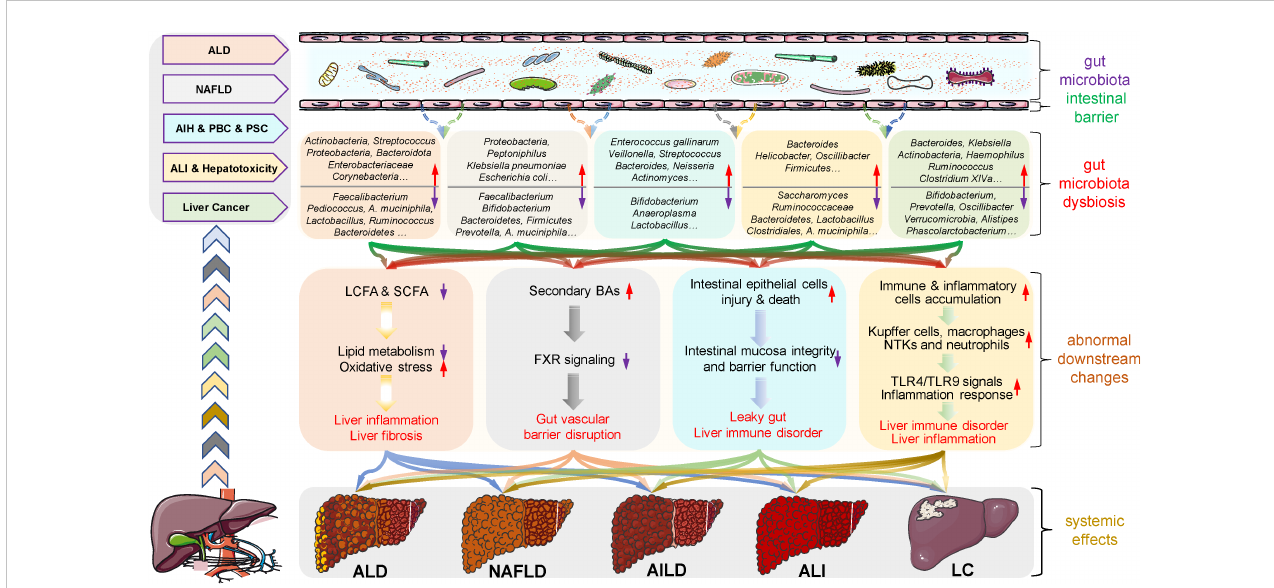
FIGURE 2 Roles of gut microbiota microenvironment alterations in the occurrence and development of liver diseases. There is growing evidence that gut microbiota dysbiosis is closely associated with the development and progression of several liver diseases, such as alcoholic liver disease (ALD), nonalcoholic fatty liver disease (NAFLD), autoimmune liver disease (AILD), acute liver injury (ALI) and liver cancer (LC). Speci fi cally, alcohol exposure, drugs and other factors induce dysbiosis in the diversity and abundance of gut microbiota species including probiotic, neutrophilic and pathogenic bacteria, as well as abnormal changes in metabolites. These changes subsequently contribute to increased intestinal permeability, intestinal barrier dysfunction, and fl ora shifts, which in turn accelerate the progression of these diseases through multiple mechanisms, such as the fatty acid metabolic pathway, bile acid (BA) metabolic pathway, in fl ammatory responses, and immune disorders. These fi ndings re fl ect the nonnegligible role of gut microbes in the regulation of liver disease and provide valuable clues and directions for the treatment of liver disease. AIH, autoimmune hepatitis; AILD, autoimmune liver disease; ALD, alcoholic liver disease; ALI, acute liver injury; BA, bile acid; FXR, farnesoid X receptor; LC, liver cancer; LCFA, long-chain fatty acid; NAFLD, nonalcoholic fatty liver disease; NTKs, natural killer cells; PBC, primary biliary cholangitis; PSC, primary sclerosing cholangitis; SCFA, short-chain fatty acid; TLR, toll-like